Question: Name the type of graph shown.
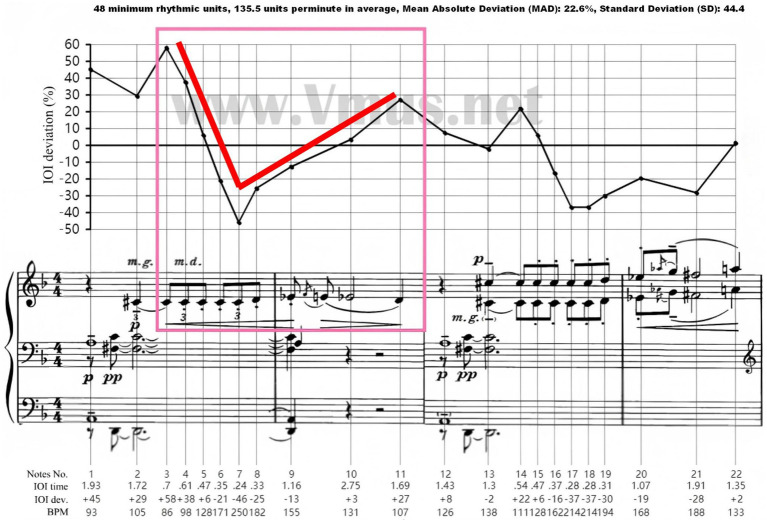
Answer: line